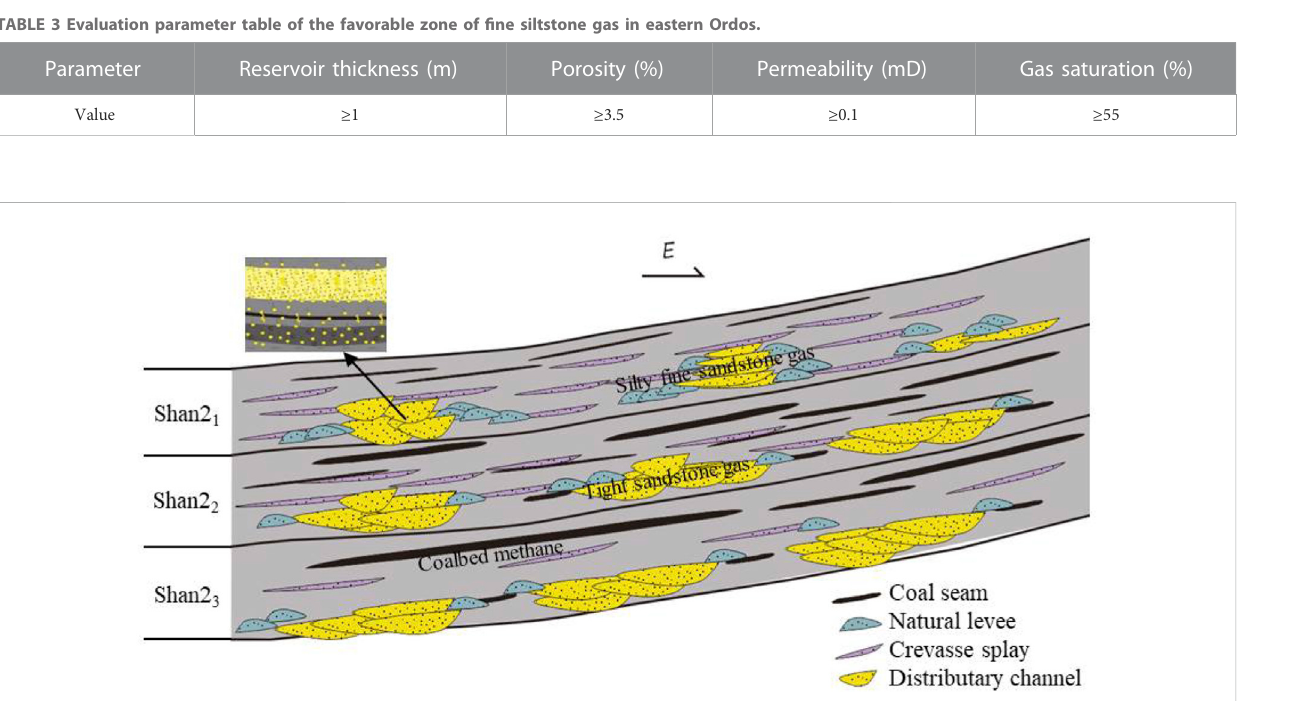
FIGURE 3 Accumulation pattern of sandstone – mudstone – coal associations in coal-bearing strata.